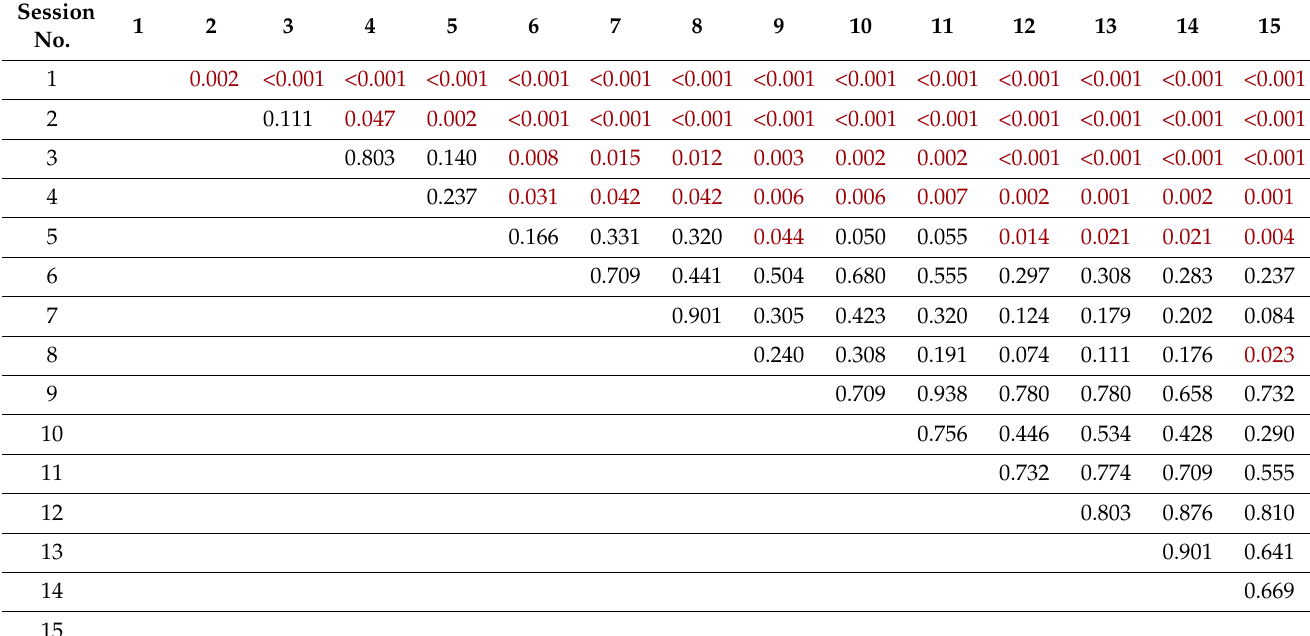
Table 7. Results of the Wilcoxon Rank Sum Test for the simulation of impostor attack. The p -values lower than 0.05 (which means significant differences between groups) are marked in red.